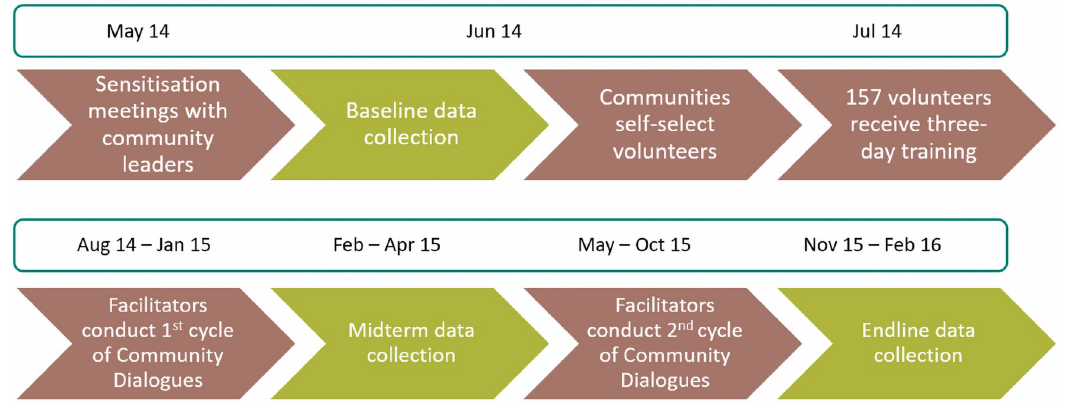
Fig 3. Study implementation and data collection